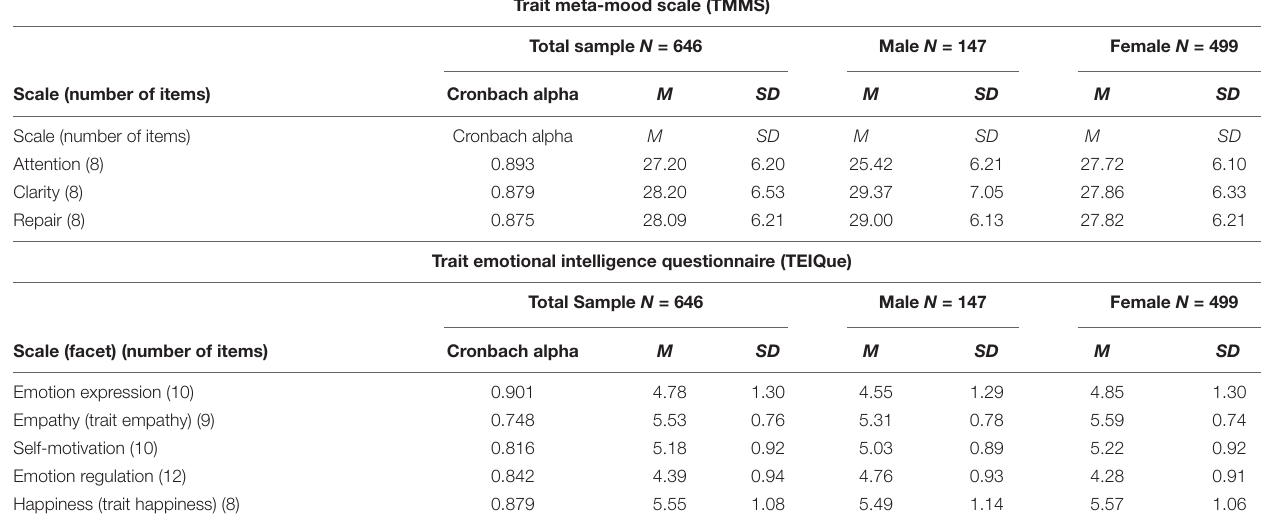
Trait meta-mood scale